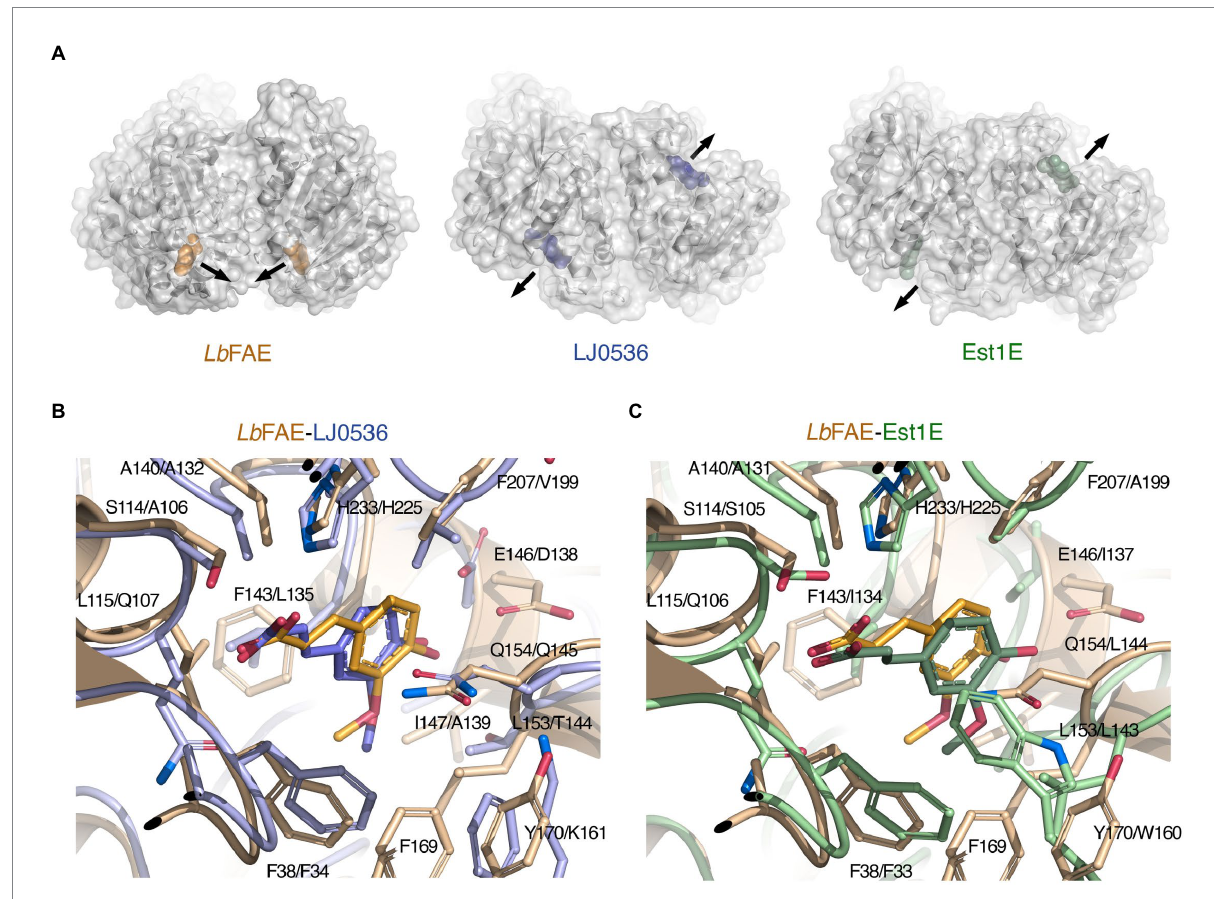
FIGURE 7 Comparison of Lb FAE with the closest known FAE structures. (A) Ribbon drawings with overlaid molecular surfaces for Lb FAE in complex with ferulate in orange, L. johnsonii cinnamoyl esterase LJ0536 in complex with ethylferulate in blue (PDB 3PFB) and B. proteoclasticus Est1E in complex with ferulate in green (PDB 2WTN). For the LJ0536 and Est1E dimers, the active sites are situated on opposite faces of the homodimer and are surface-exposed. In Lb FAE, the active sites are facing each other and are buried below the protein surface. The arrows indicate the active- site entrances. Overlaid active site in the wild-type Lb FAE ferulate complex (orange) with the (B) S106A-LJ0536 ferulate complex (blue; PDB 3PFC), and with the (C) wild-type Est1E ferulate complex (green; PDB 2WTN). The first residue in each label is for Lb FAE. The ferulate molecule assumes identical orientations but slightly different conformation in Lb FAE and LJ0536, whereas the ferulate molecule in Est1E has a different orientation in relation to the active